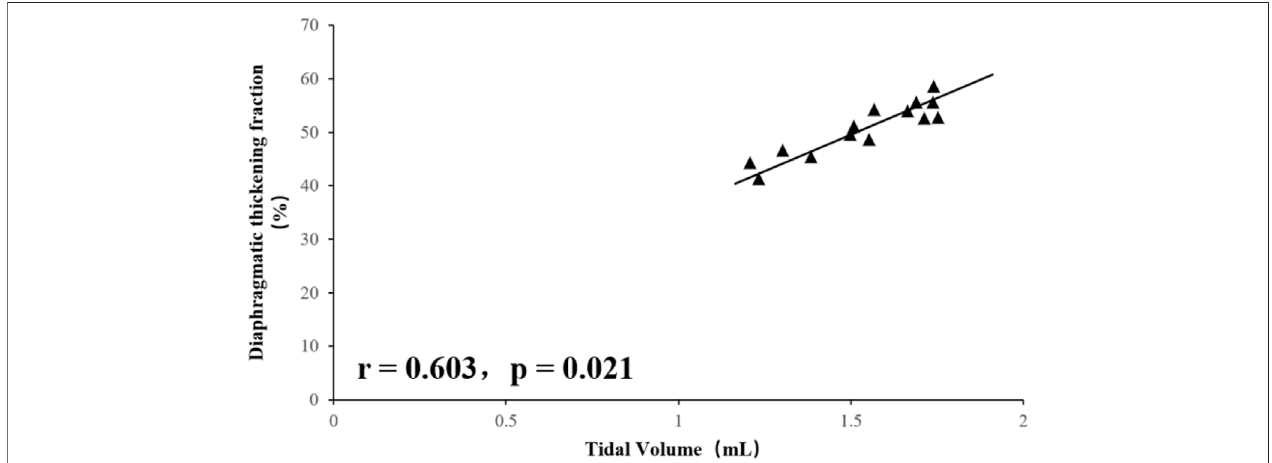
FIGURE 3 | Relationship between Tidal Volume and Diaphragm TF.